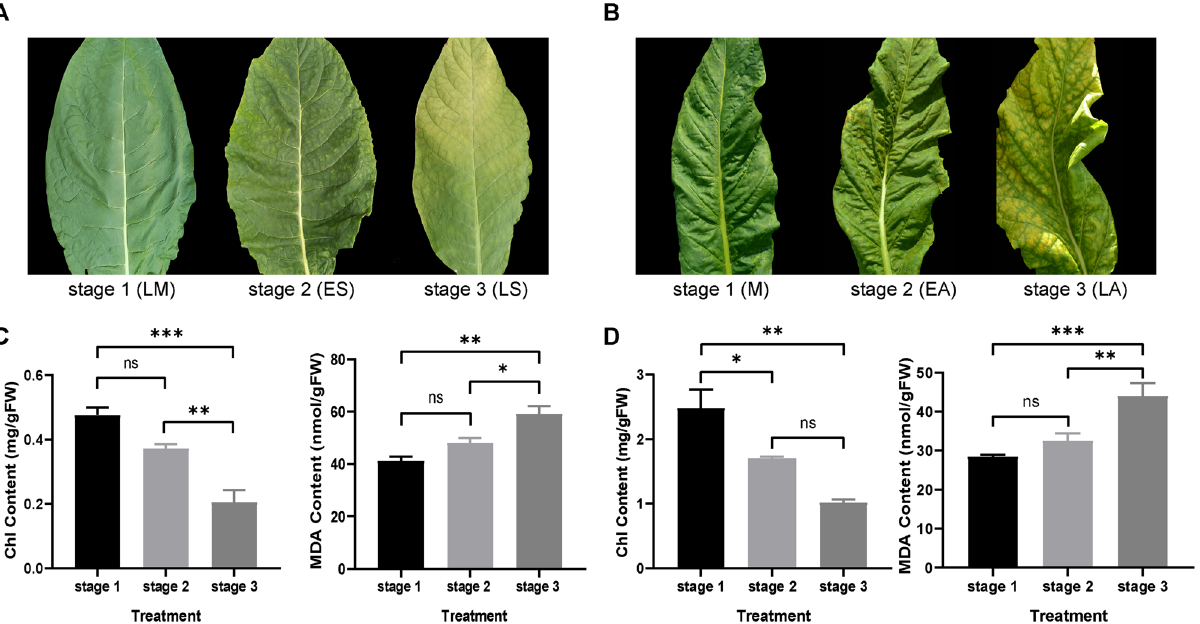
Figure 1. Morphologic characterization, chlorophyll (Chl) and malondialdehyde (MDA) contents in plants. ( A ) phenotype of developmental senescence (DS). ( B ) phenotype of premature senescence (PS). ( C ) Chl and MDA contents of leaves in DS. ( D ) Chl and MDA contents of leaves in PS. Results of Chl and MDA are shown as means ± SE. “ns” means no significant difference. *, ** and *** represent significant difference at p < 0.05, 0.01 and 0.001 respectively. B and D were adapted from our previous work 49